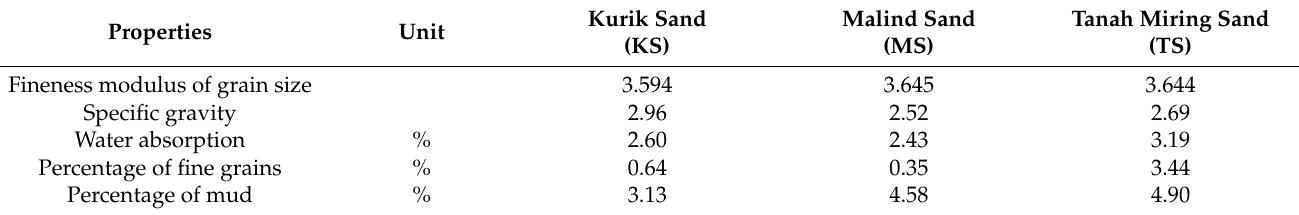
Table 1. Physical properties of pit sand.